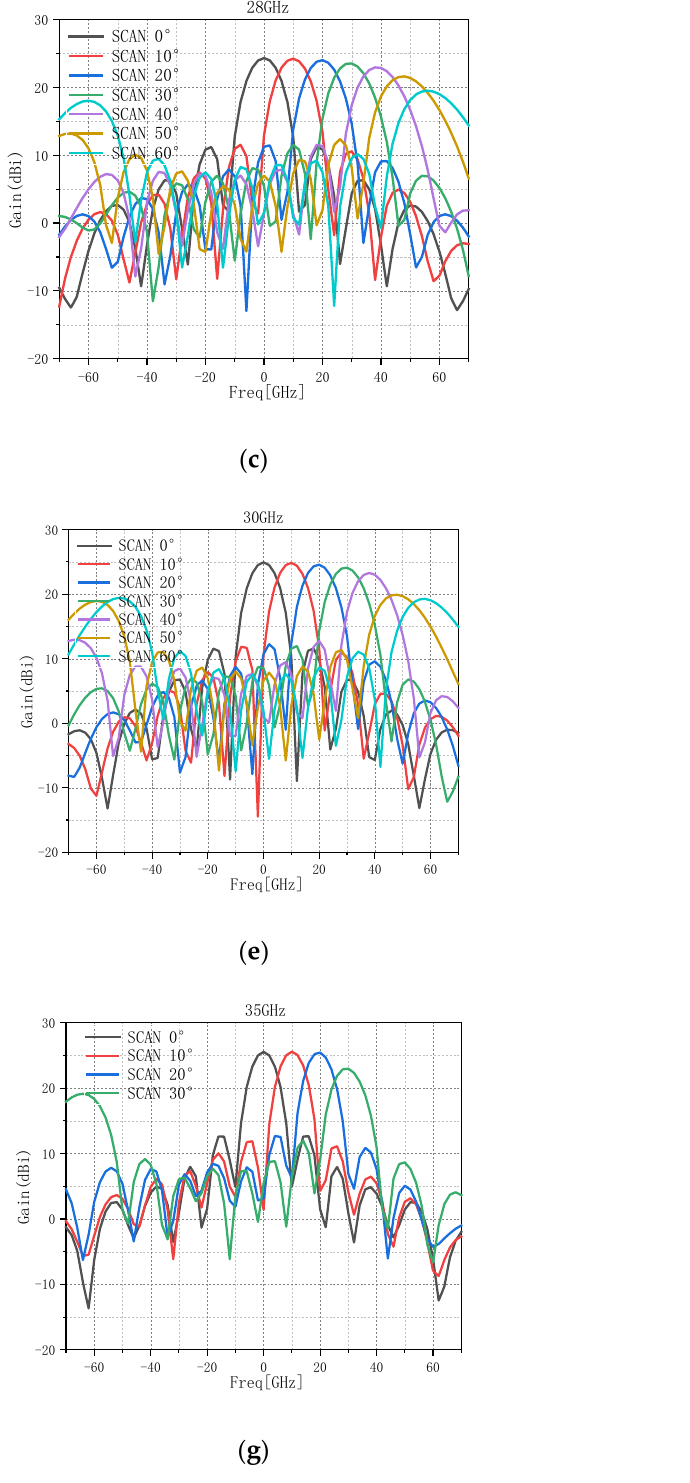
Figure 8. Antenna test direction diagram: ( a ) @26.5 GHz transmit pattern result; ( b ) @26.5 GHz receive pattern result; ( c ) @28 GHz transmit pattern result; ( d ) @28 GHz receive pattern result; ( e ) @30 GHz transmit pattern result; ( f ) @30 GHz receive pattern result; ( g ) @35 GHz transmit pattern result; and ( h ) @35 GHz receive pattern result.